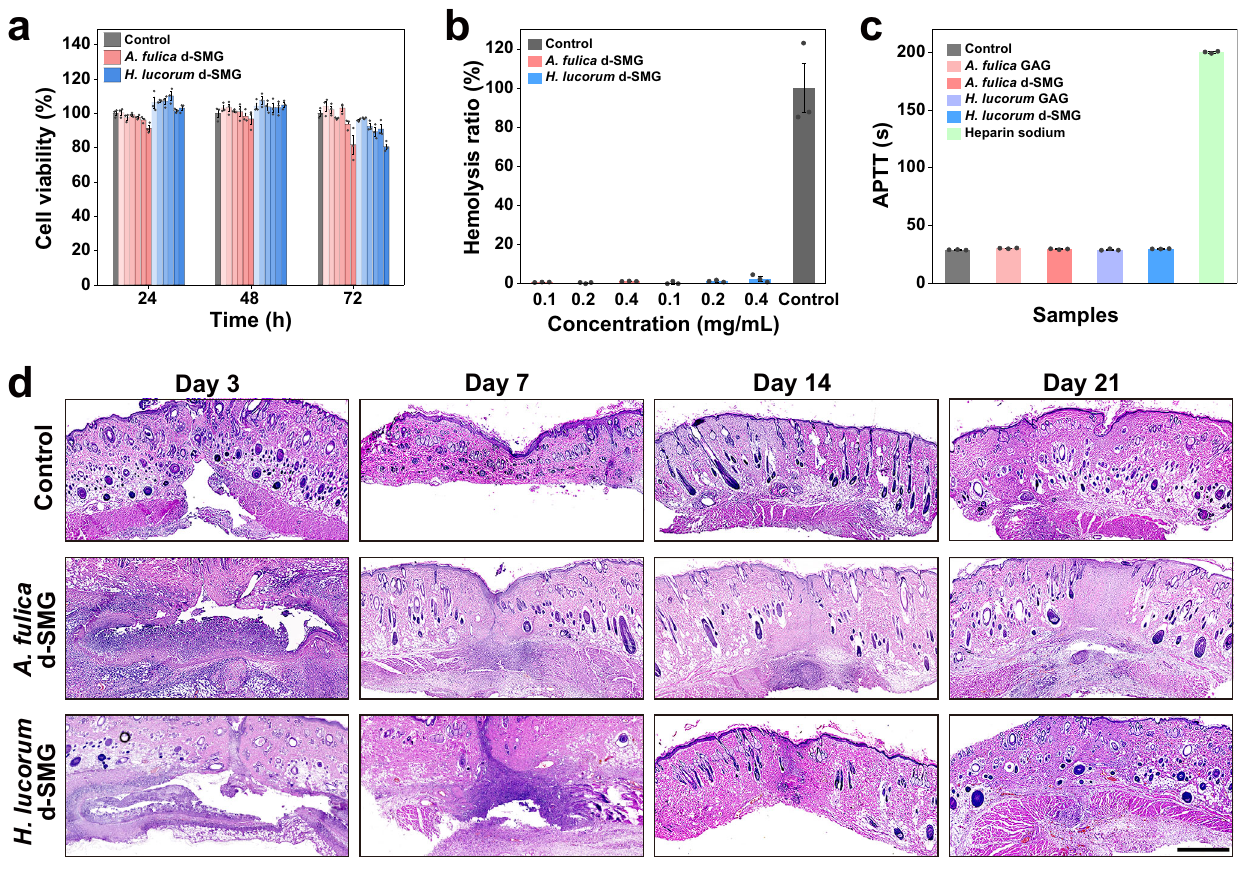
Fig. 3 | Biocompatibility and biodegradability of d-SMGs. a Effect of different concentrations (0.05, 0.1, 0.2, 0.5, 1.0, and 2.0mg/mL from left to right in the graph) of d-SMG on cell viability by MTT method ( n =3 cells examined over 3 independent experiments in each group). b Effect of d-SMGs on hemolysis ( n =3 biologically independent samples in each group). c Effect of d-SMGs and their